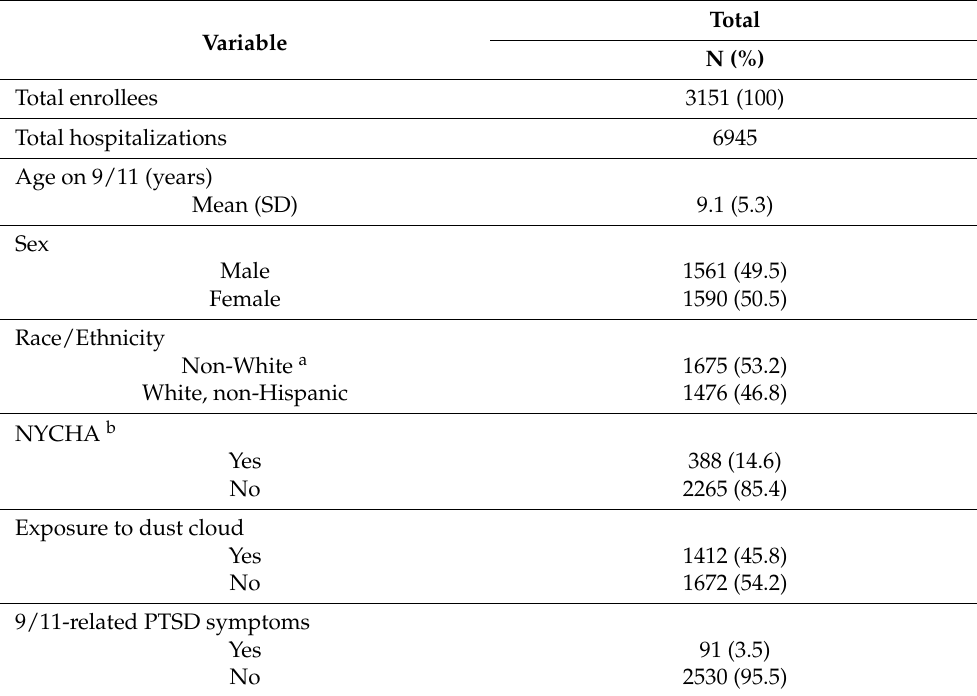
Table 1. Characteristics of World Trade Center Health Registry enrollees residing in New York State who were <18 years of age on